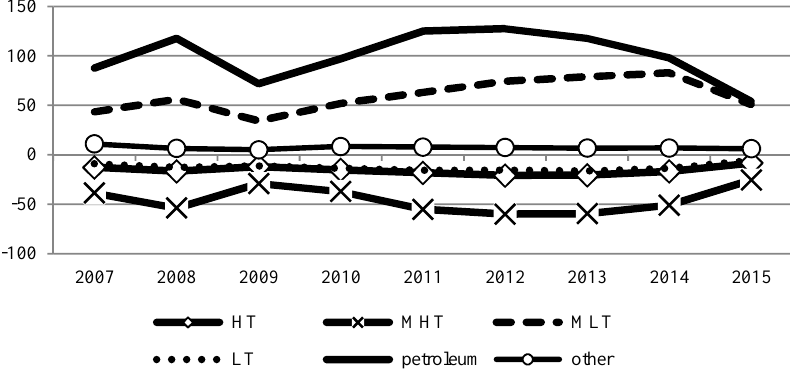
Figure 5. Trade balance in Russian trade exchange with the EU28 in 2007–2015 (billion USD)